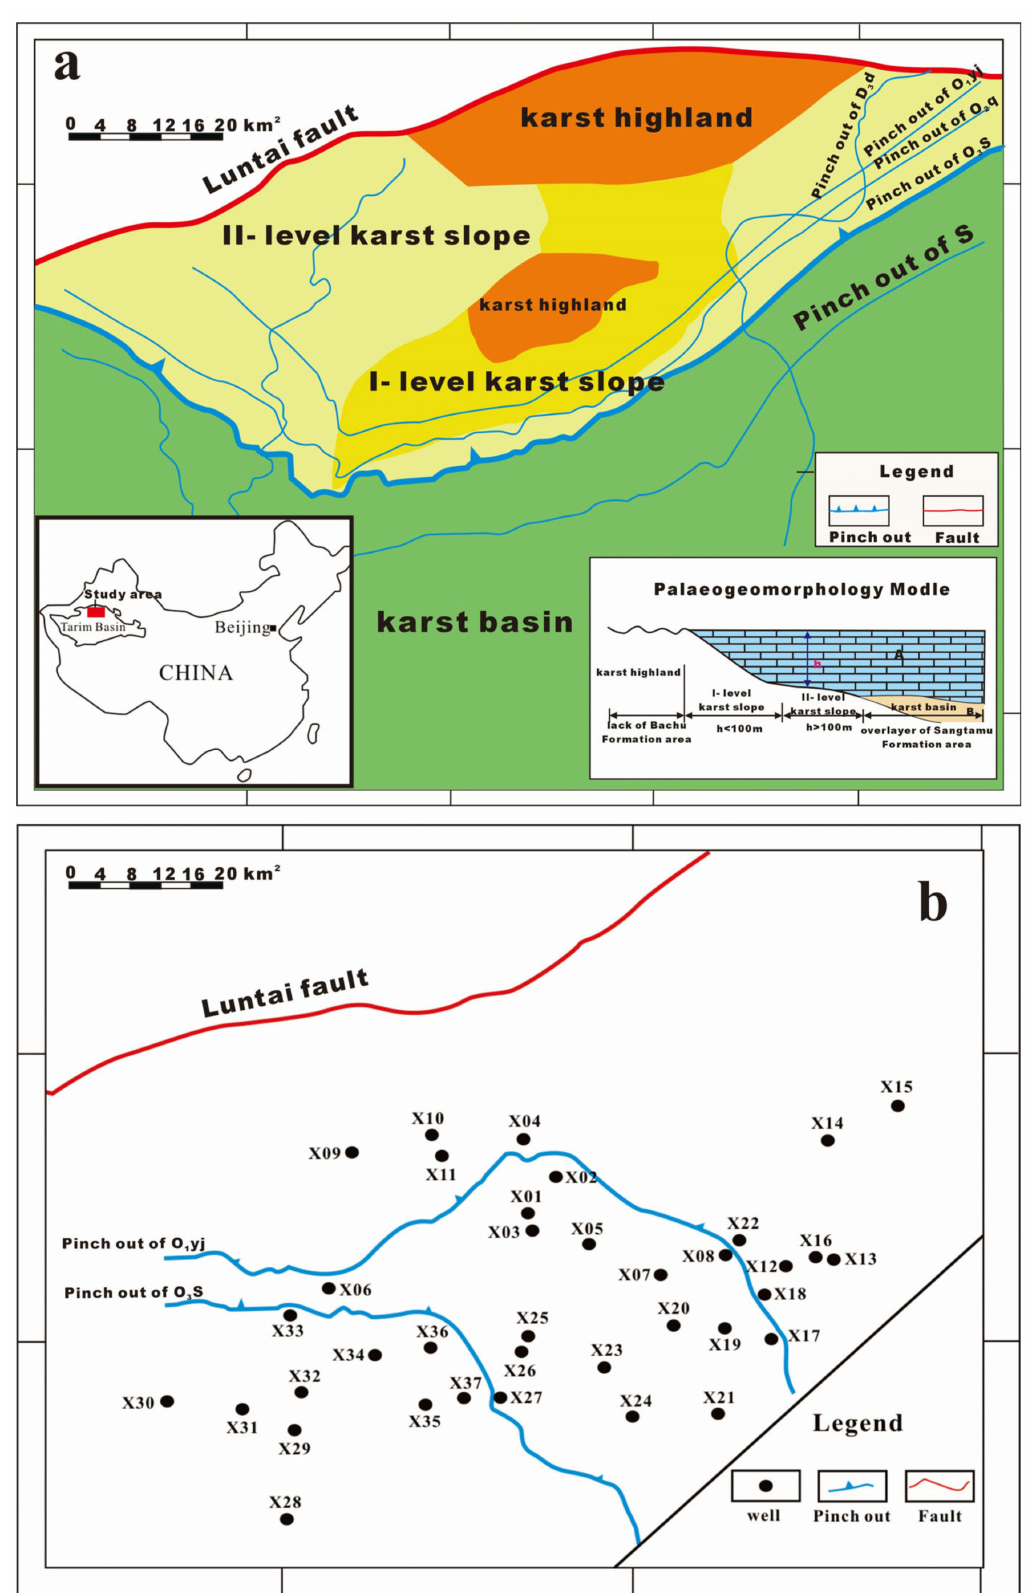
Figure 1. Early Hercynian karst paleo-topography of Tahe oilfield ( a ) and study well in the study area ( b ) (modified from